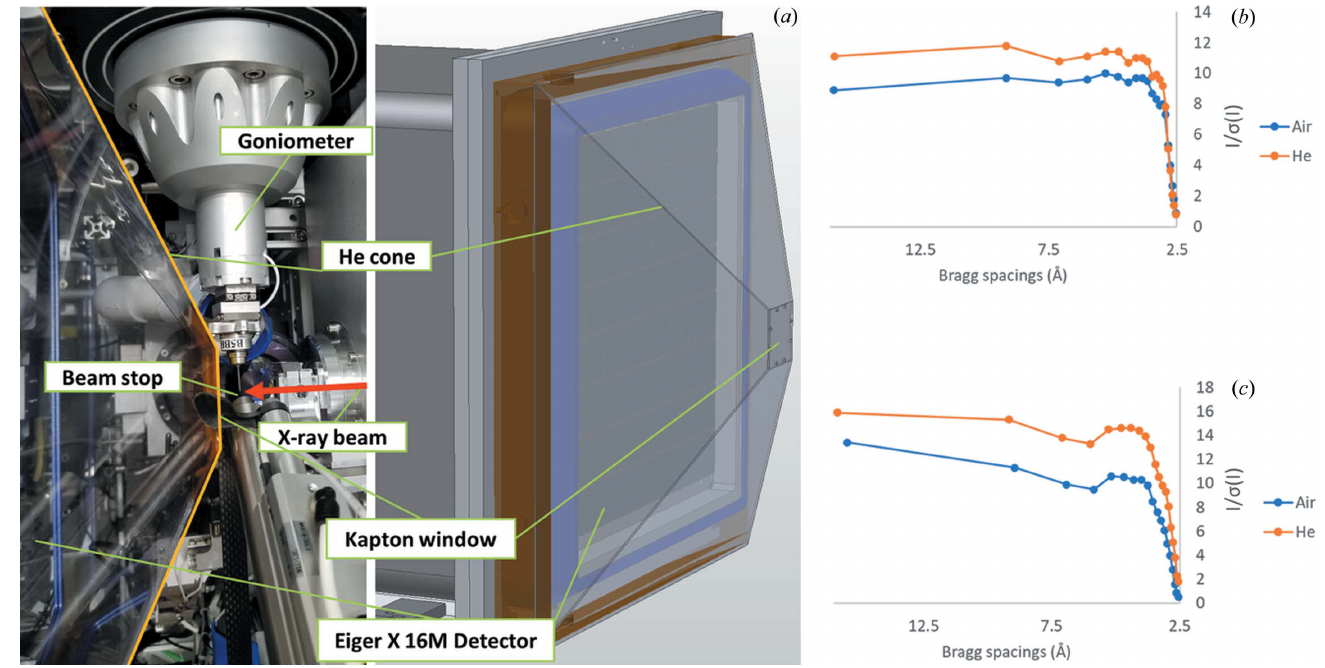
Figure 1 A helium environment for low-energy X-ray experiments. ( a ) The helium path setup at the FMX experimental station. The X-ray beam passes through the nitrogen cooling gas stream after exiting the beam collimator tube 5 mm upstream of the crystal into the beamstop 5 mm downstream of the crystal. The scattered radiation passes through a Kapton window with a thickness of 7.62 m m at a distance of 12 mm downstream of the sample position. The detector surface of the EIGER X 16M detector is at 137 mm downstream of the crystal position. ( b ) and ( c ) Plot of h I / (cid:3) ( I ) i against d min . Highest signal- to-noise among single-crystal dataset of ( b ) thaumatin or ( c ) TehA included 1620